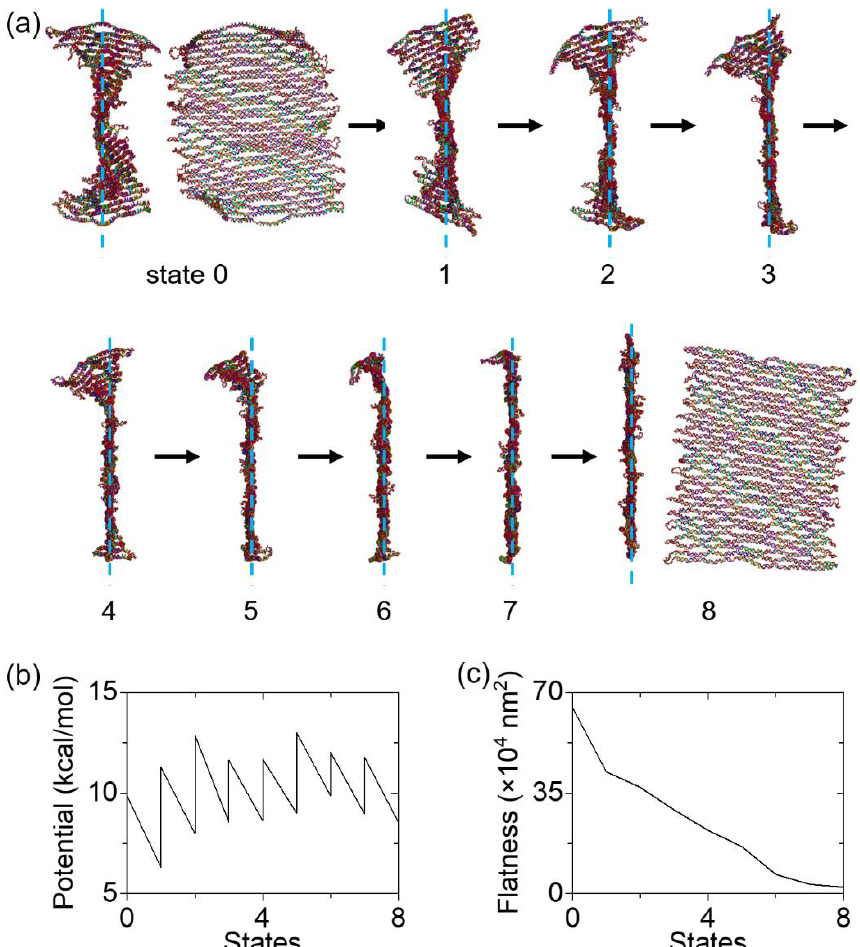
Figure 5. Flattening process of a DNA origami tile in MD simulations. ( a ) The origami tile flattens from the initial state (state 0) and undergoes gradual planarization until the final state (state 8). The flattening is induced by pulling all the nucleotides to the imaginary flat plane at the center (dashed turquoise line) with hypothetical springs. In the final state, the origami tile is planar. ( b ) External potential landscape during the flattening process. The external work was calculated in a similar approach as in the cyclization process. ( c ) Flatness during the flattening. This is a sum of the distance squared of each nucleotide to the imaginary flat plane. Given the radius of a dsDNA bundle (~1.1 nm), the flatness of a planar tile is ~2 × 10 4 nm 2 . During the deformation, the flatness starts from ~6.5 × 10 5 nm 2 and ends at ~2.3 × 10 4 nm 2 .